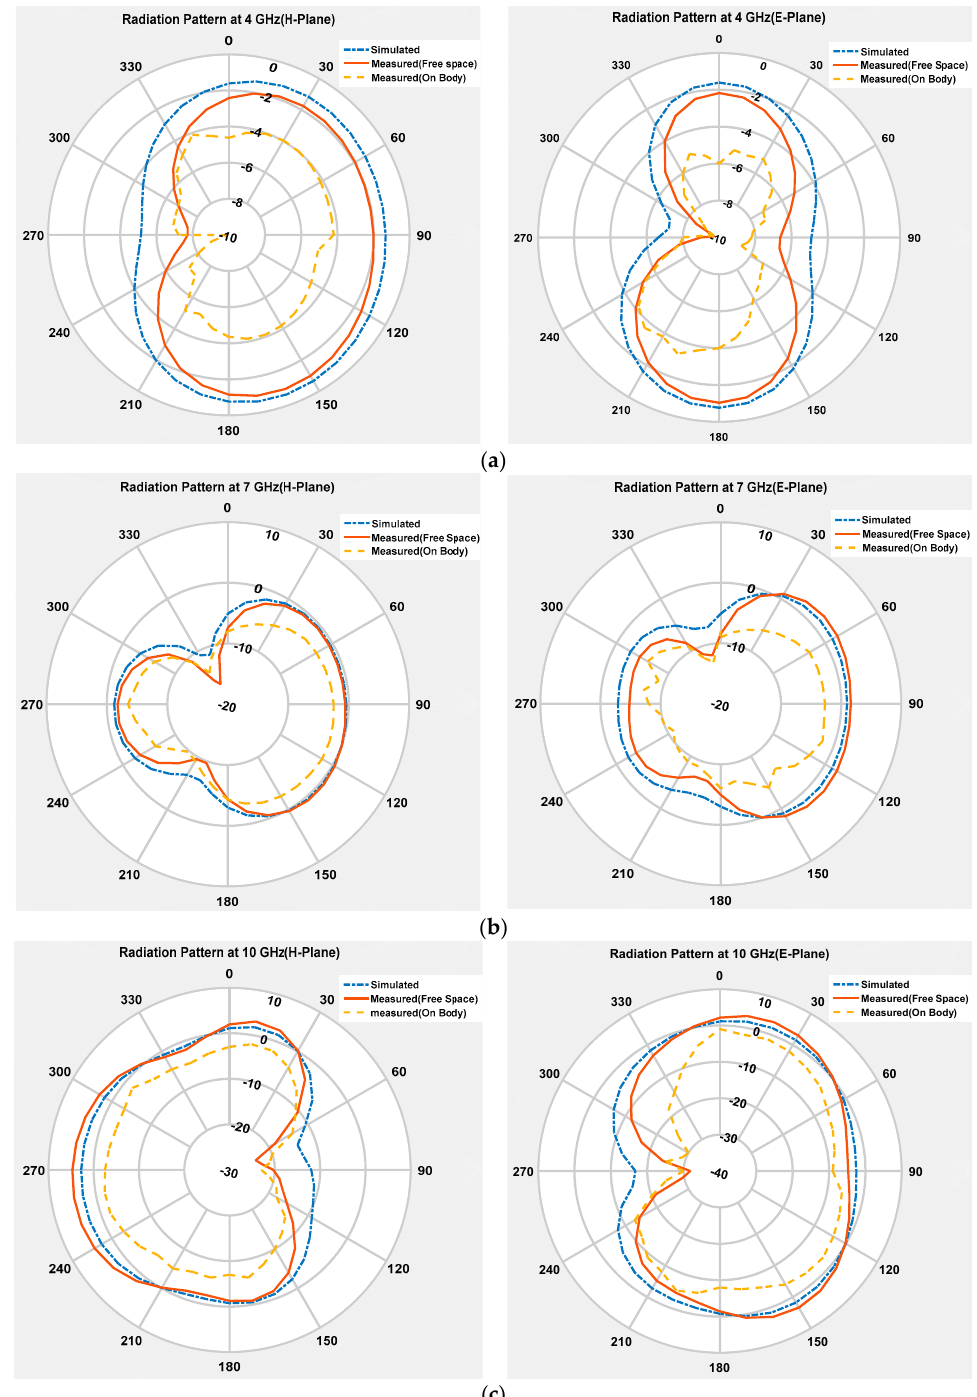
Figure 14. Simulated and measured radiation pattern at 4 GHz ( a ), 7 GHz ( b ) and 10 GHz ( c ) frequencies.